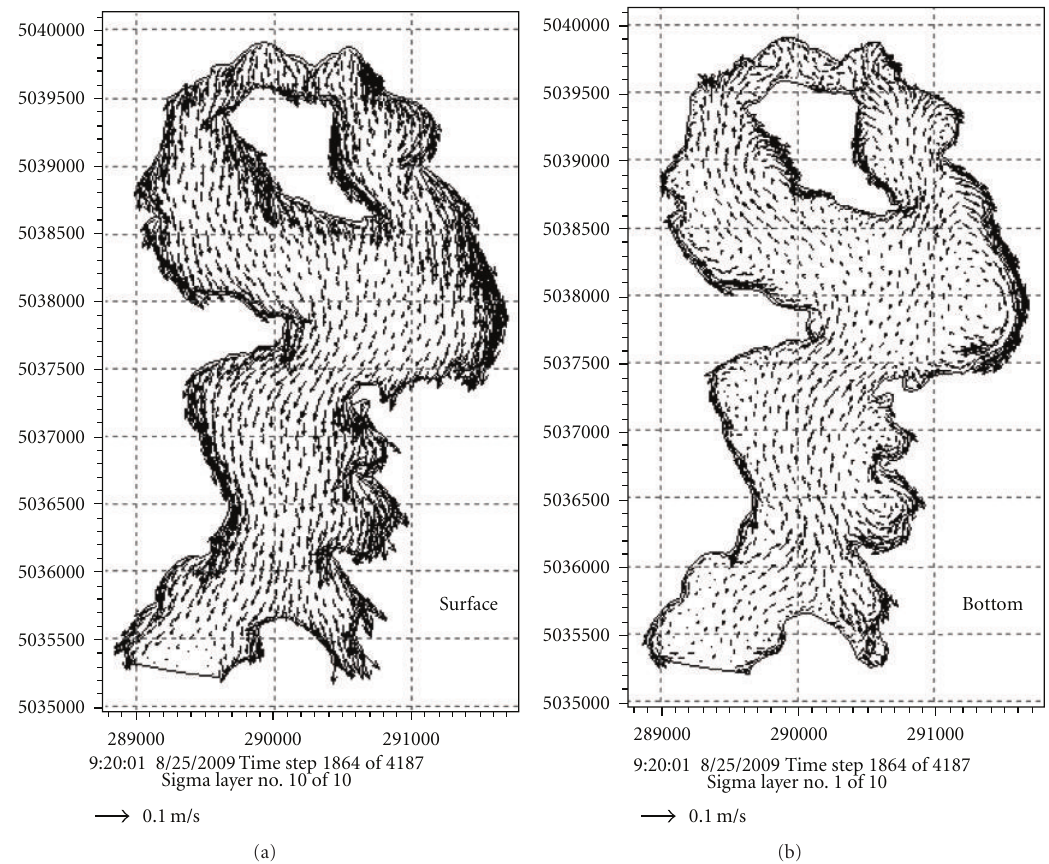
Figure 11: The simulated surface and bottom flow patterns at the Julian 237.7 day (having the strongest recorded north wind).